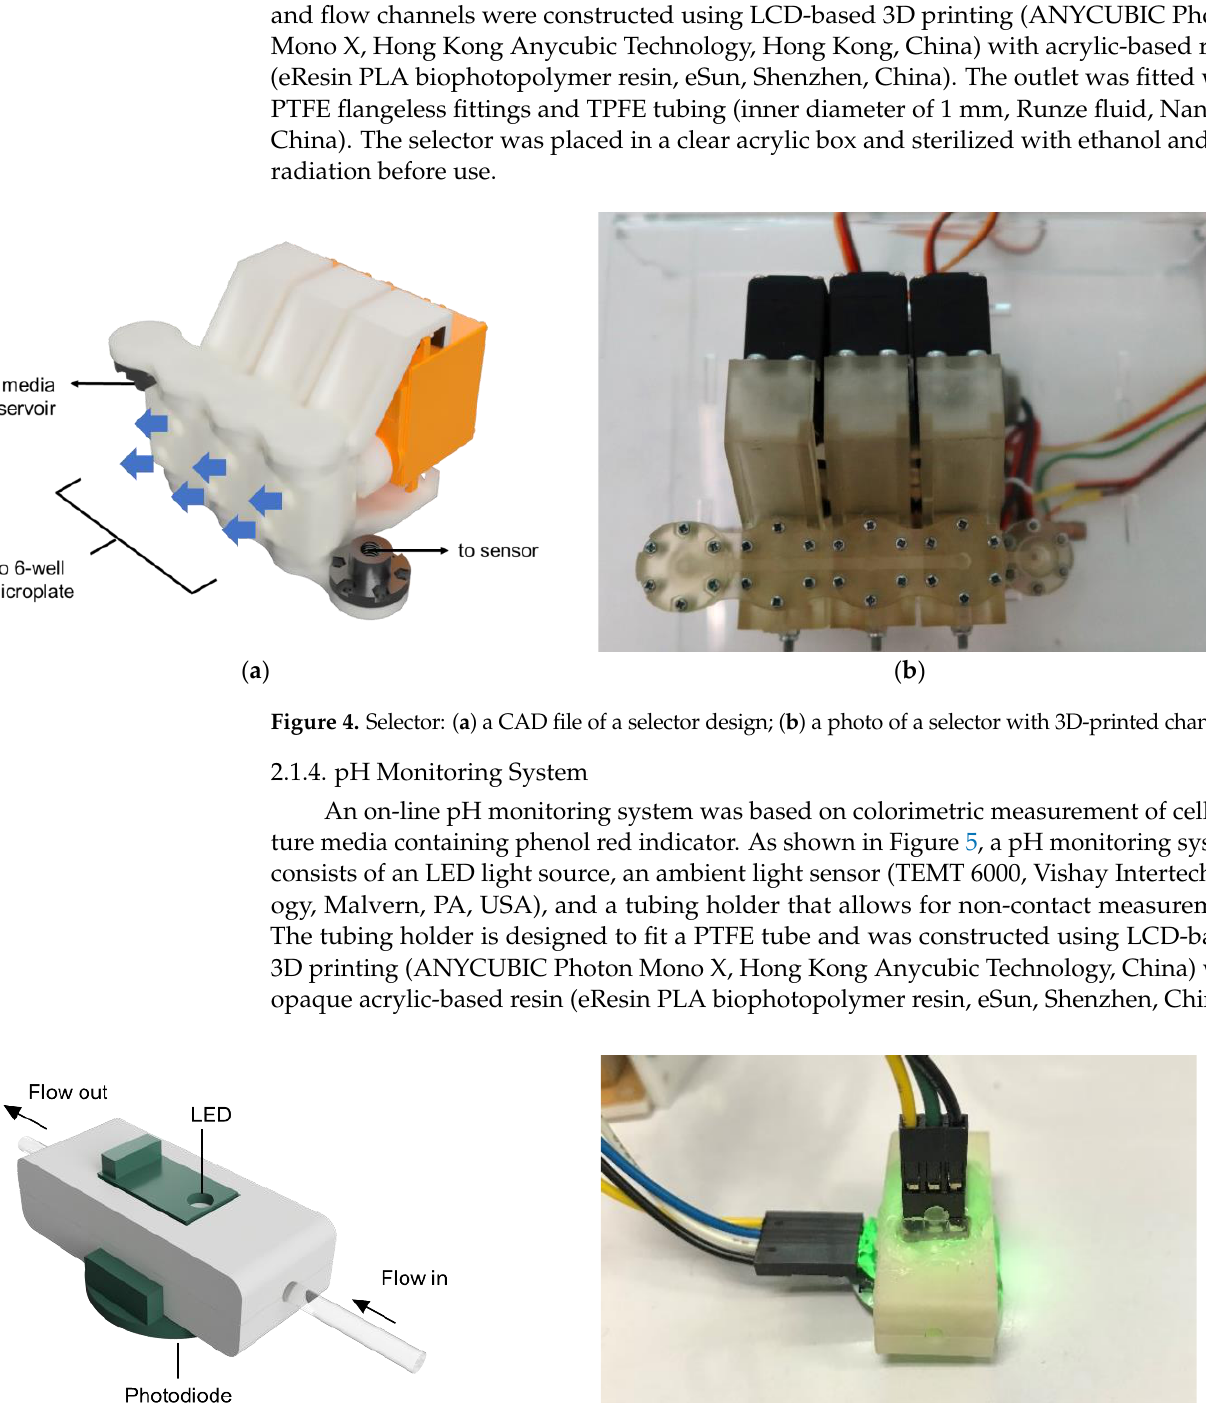
Figure 3. Syringe pump: ( a ) a CAD file of syringe pump design; ( b ) a photo of syringe pump with a 10-mL syringe in an acrylic box.